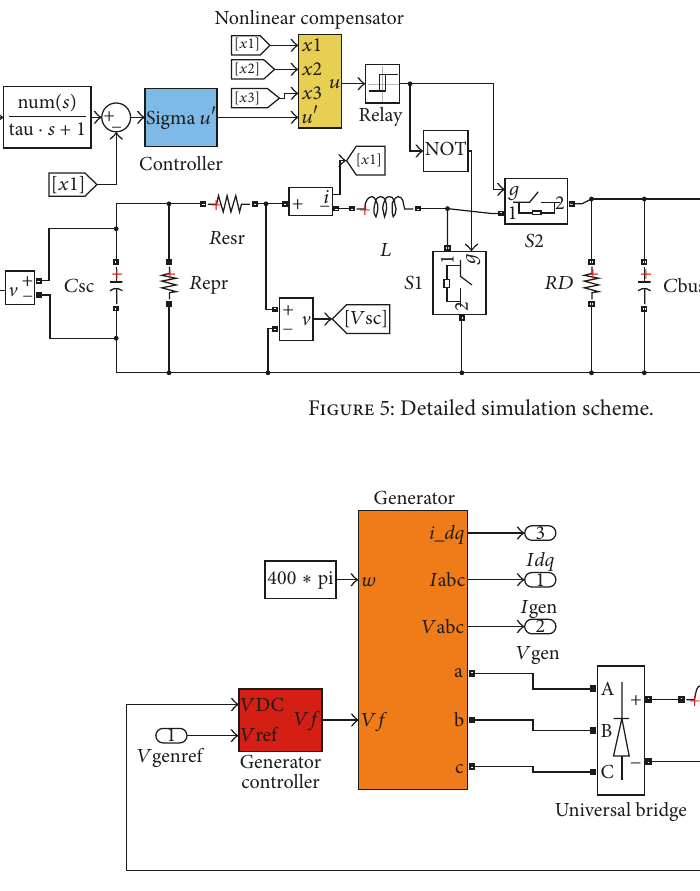
Figure 6: 𝐸 𝐻 : controlled generator scheme.